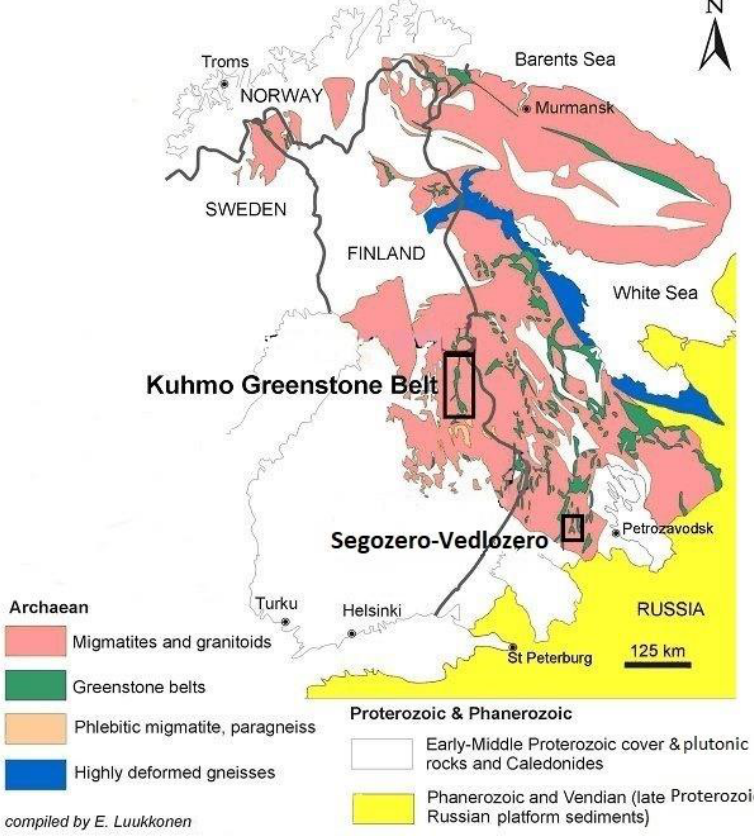
Figure 1. The geological structure of Karelia and location of the studied areas [12].